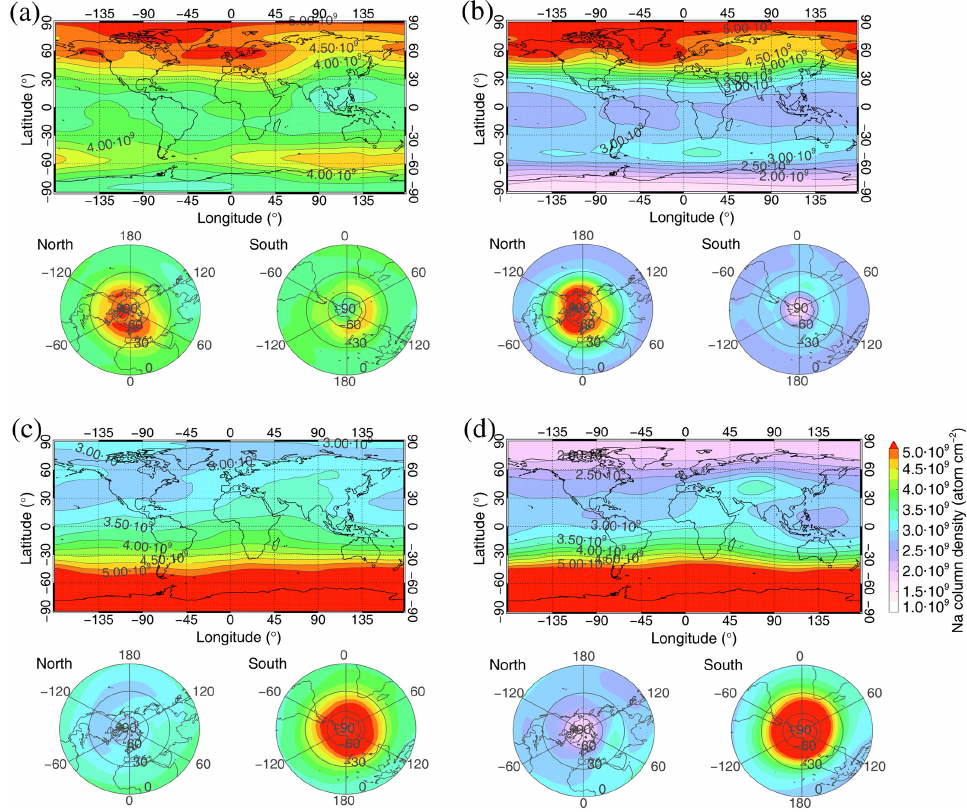
Figure 7. Seasonal variations in the WACCM simulated Na column number density during the period 2004 to 2009. Maps for (a) autumn (September, October, November), (b) winter (December, January, February), (c) spring (March, April, May), and (d) summer (June, July, August).